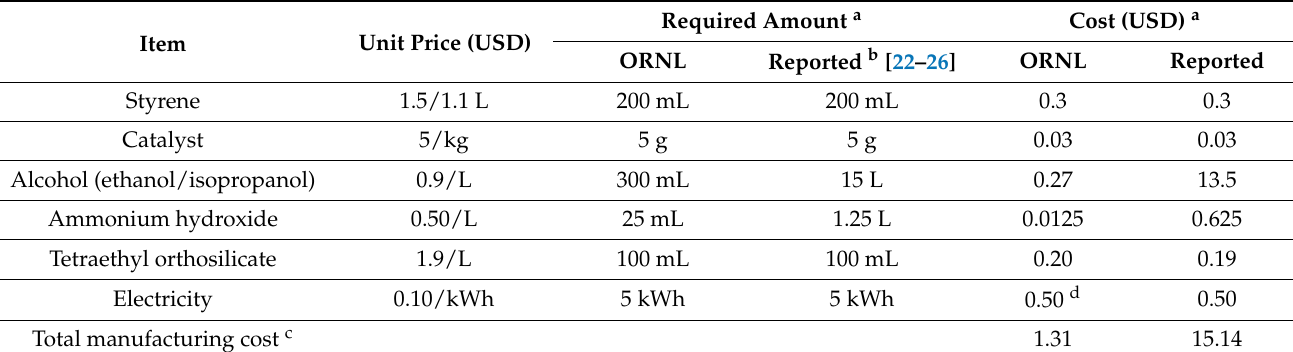
Table 1. Cost analysis of ORNL hollow silica particle manufacturing process compared with the currently reported processes